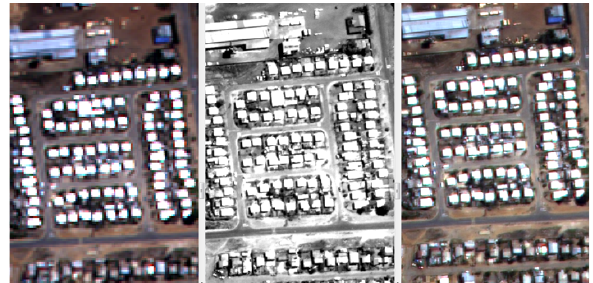
Figure 2. From left to right: multispectral, panchromatic, and pan-sharpened WorldView-2 Image Copyright 2014, DigitalGlobe ©